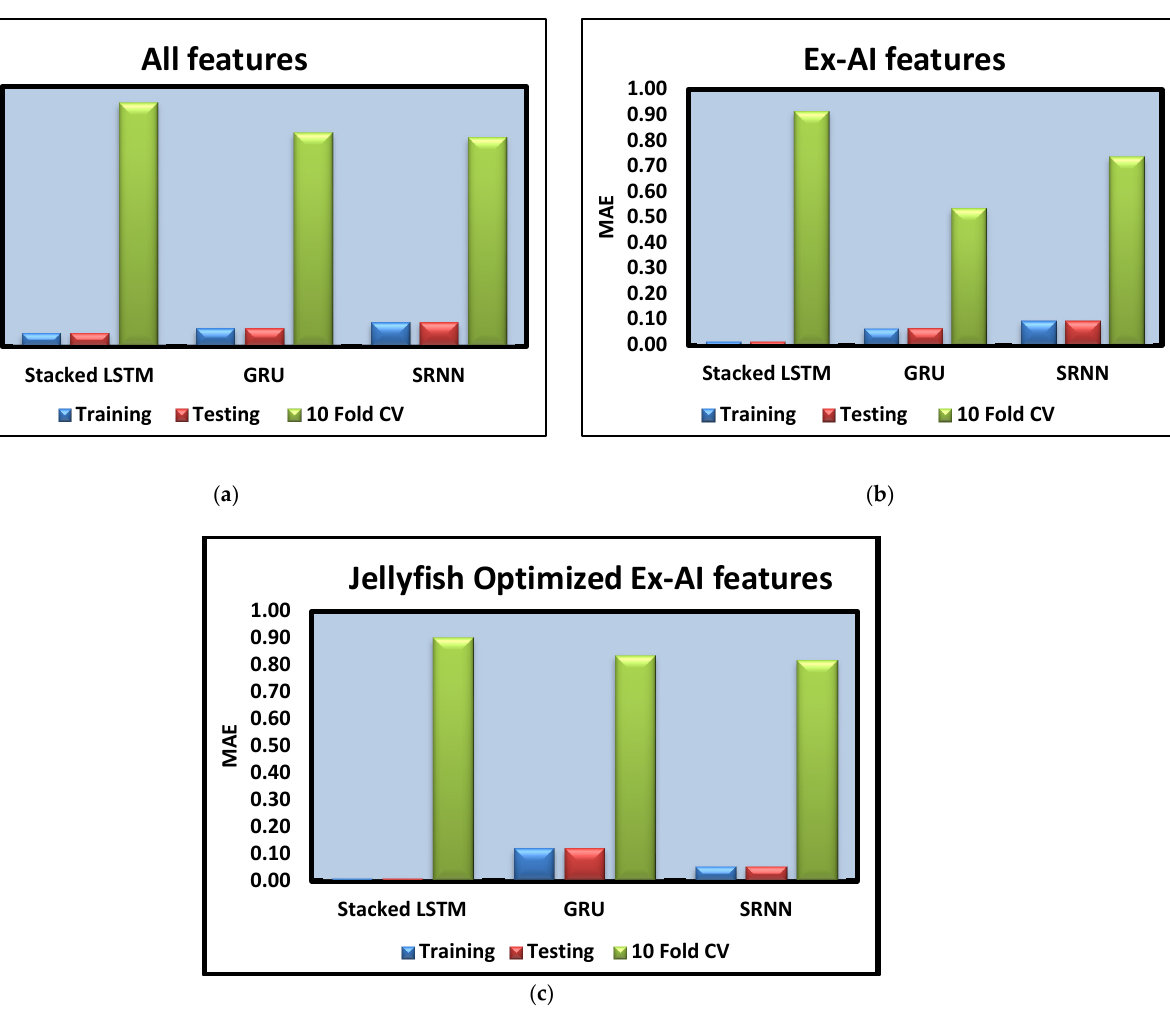
( c ) Figure 13. ( a – c ) MAPE values from three models. ( a ) All features. ( b ) Ex-AI features. ( c ) Jellyfish- optimized Ex-AI features.